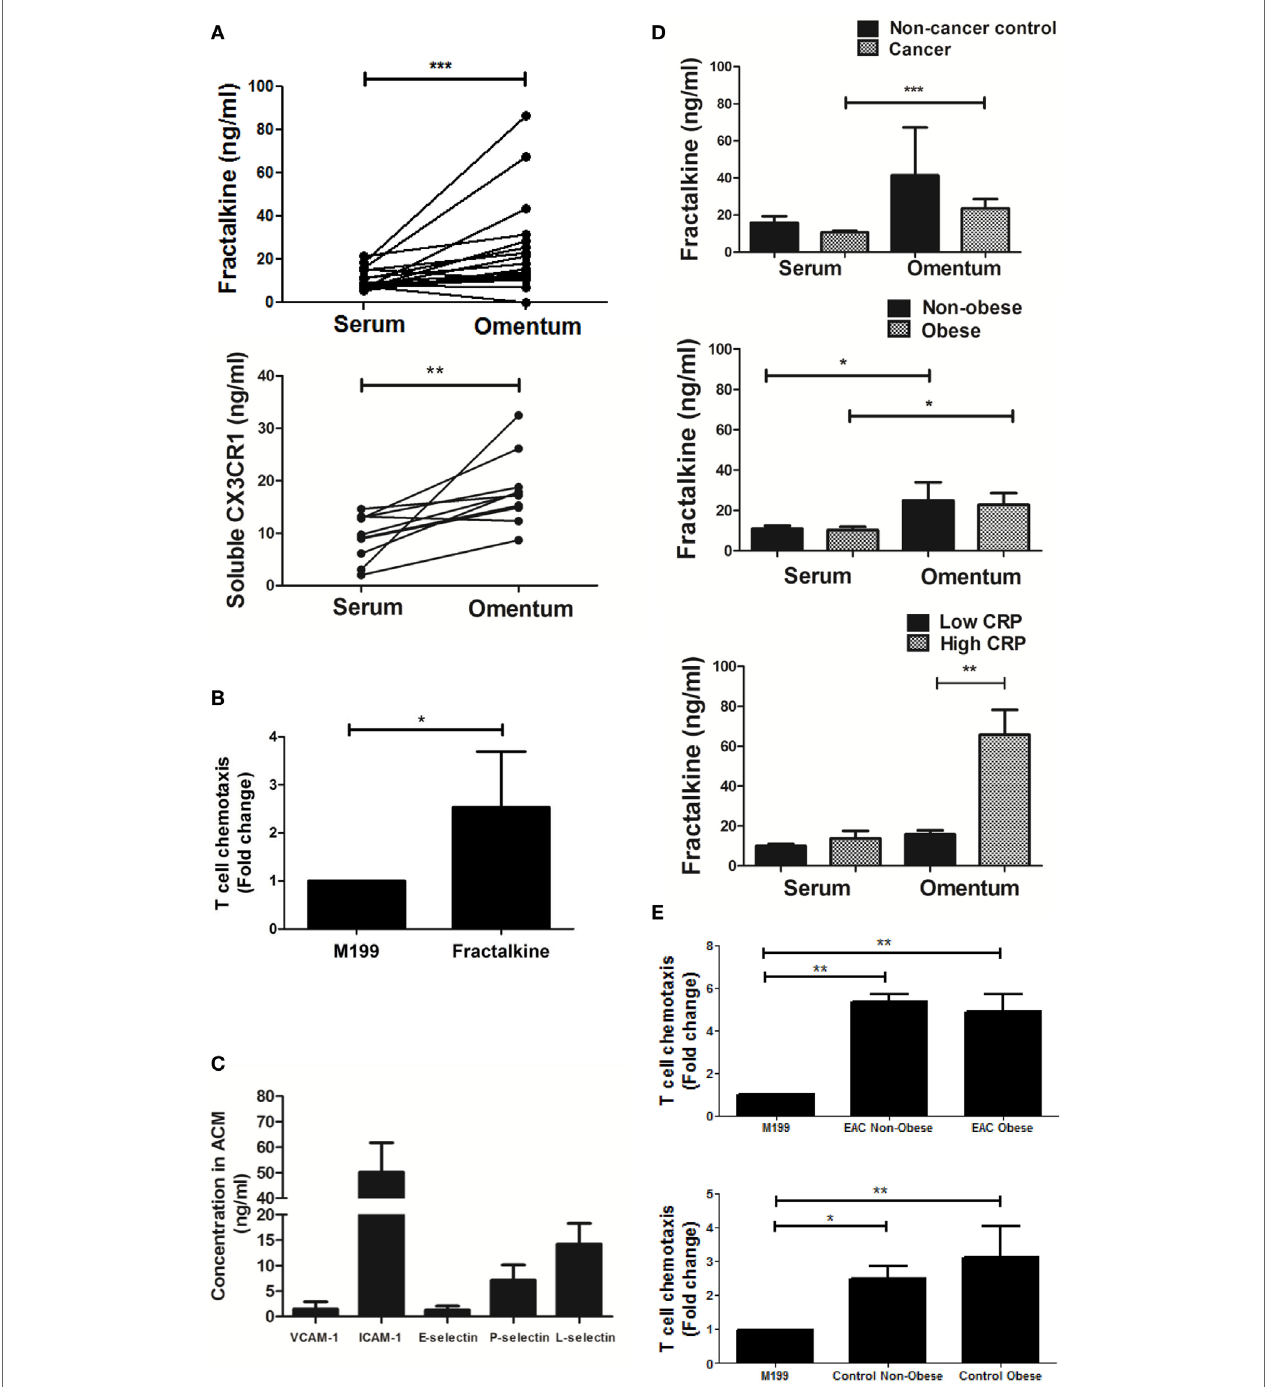
FigUre 1 | Both soluble fractalkine and CX3CR1 are secreted in abundance in the omentum of esophagogastric adenocarcinoma (EAC) patients and fractalkine can drive migration of EAC patient-derived T cells. (a) Scatter plots showing the fractalkine (top) and soluble CX3CR1 levels (bottom) in paired samples of serum and adipose tissue conditioned media (ACM) from 10 to 19 EAC patients. (B) Bar charts showing significant fold change migration of peripheral blood-derived T cells from five EAC patients to M199 media supplemented with 30 ng/ml of recombinant fractalkine, relative to M199 alone negative control. (c) Bar charts showing the levels of soluble VCAM-1, ICAM-1, E-selectin, P-selectin, and L-selectin in omental adipose tissue conditioned media (ACM) from five EAC patients. (D) Bar charts showing the fractalkine levels in serum and ACM from 3 non-cancer control subjects and 20 EAC patients, from 9 non-obese and 11 obese EAC patients, and 17 EAC patients with serum C-reactive protein (CRP) < 5 mg/l (low CRP) and 3 EAC patients with serum CRP > 5 mg/l (high CRP). (e) Bar charts showing significant fold change migration of peripheral blood-derived T cells to ACM from three non-obese and four obese EAC patients and three non-obese and two obese non-cancer controls. * p < 0.05, ** p < 0.01, *** p < 0.001 by paired, unpaired t tests and one-way ANOVA with Tukey post hoc analysis.